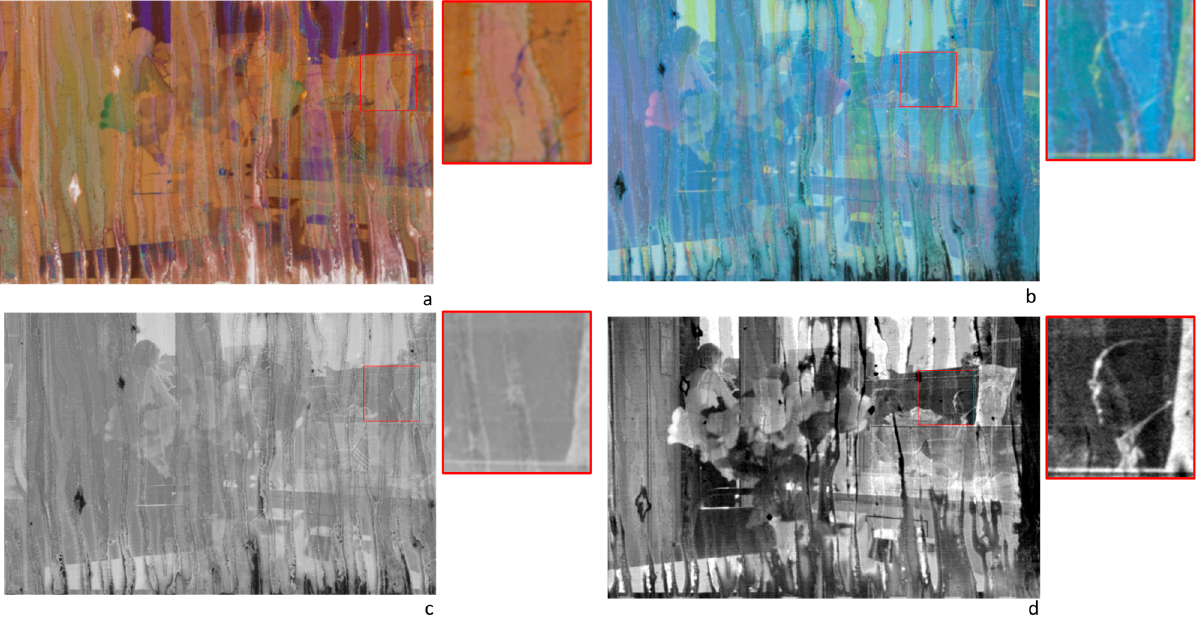
Figure 5. Elaborated HSI data set acquired on the fourth photogram of the fi lm-strip negative re- ported in Figure 4. The fourth photogram and zoom on the selected area (red square). Comparative view of the di ff erent elaborations: ( a ) sRGB image reconstructed from the HSI spectral data; ( b ) positive color image; ( c ) B&W image obtained by the positive image in greyscale; ( d ) PCA analysis in the 420–900 nm range: PC3 image .